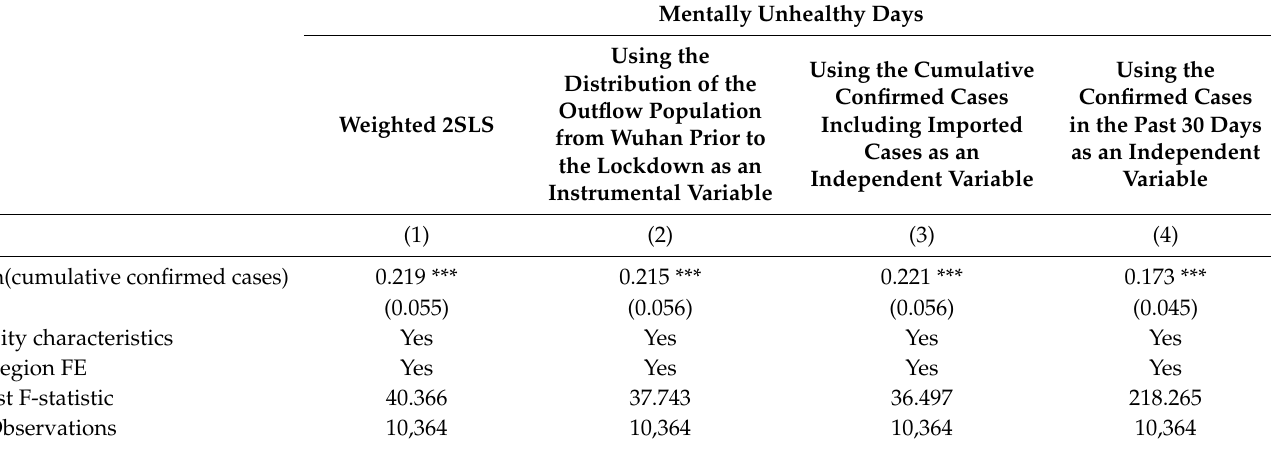
Table 3. Robustness